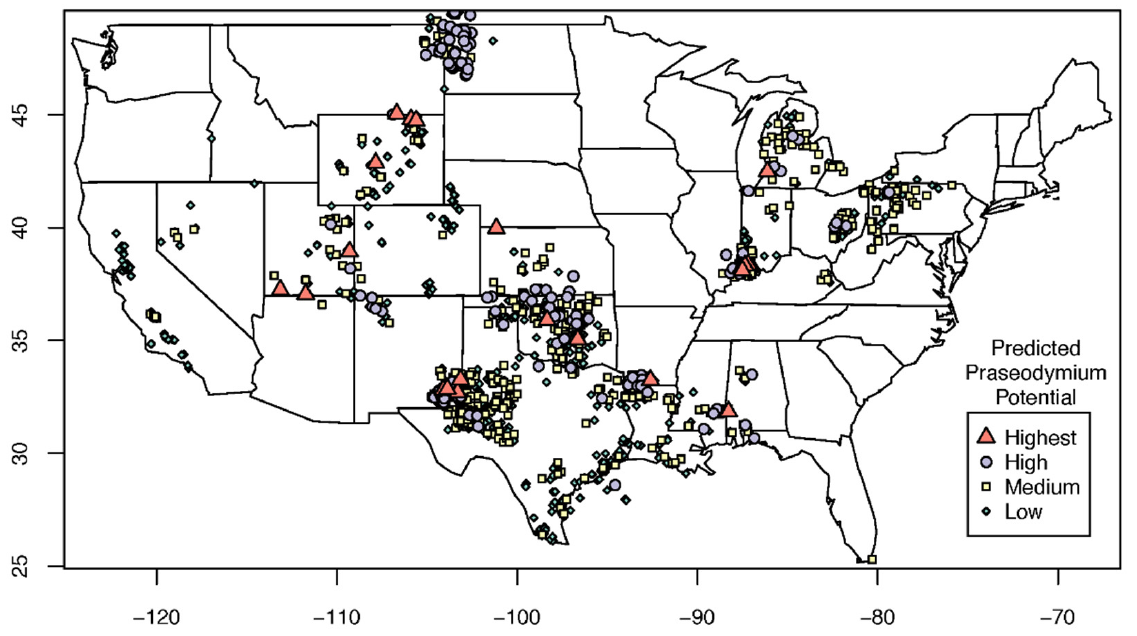
Figure 7. Predicted Pr potential of produced and geothermal waters. Predicted potential categories: highest ≥ 500, high = 100–499, medium = 10–99, low < 10.